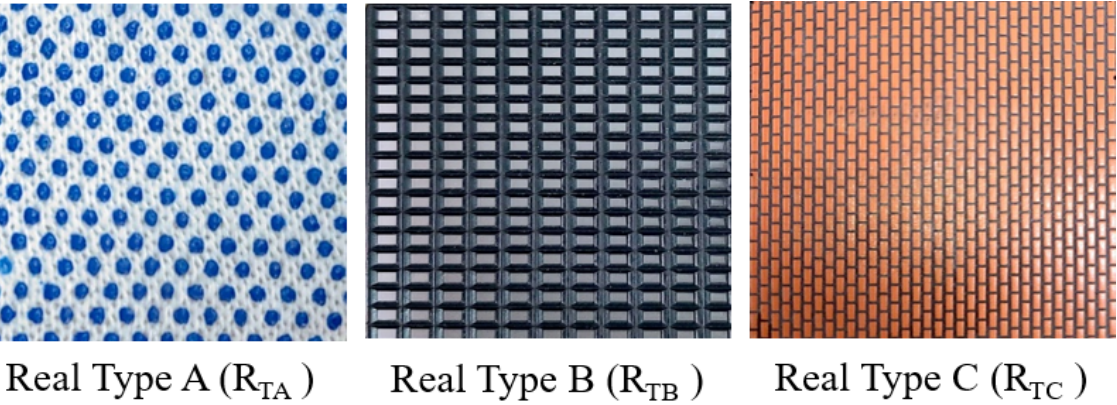
Figure 5. Different types of texture surfaces used for texture rendering.